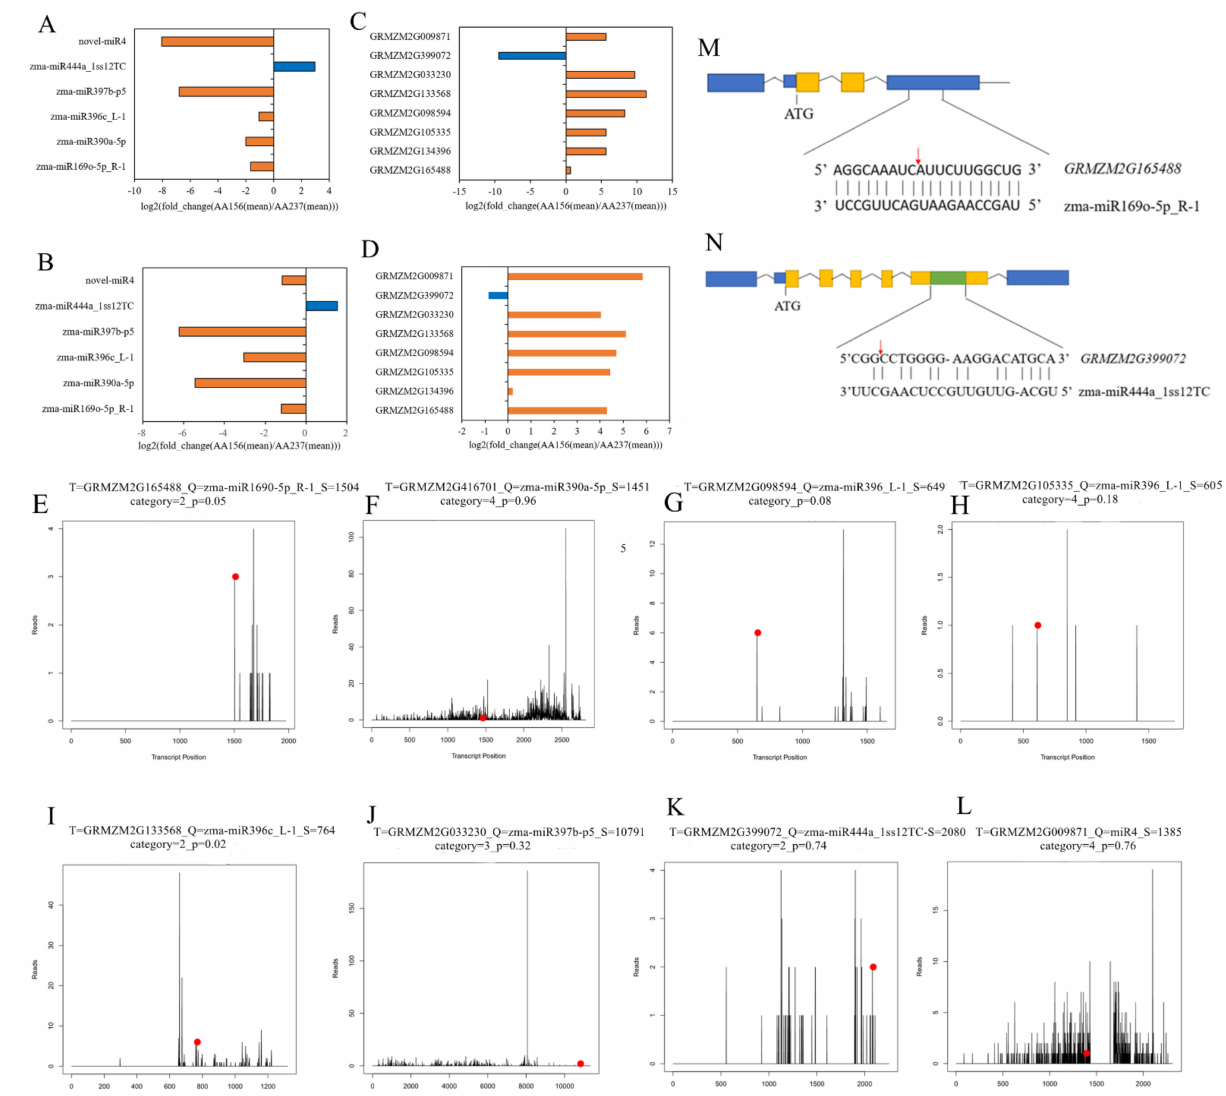
Figure 3. The miRNA, target, and degradation product abundances by RNA seq and validation by alternative methods. ( A ) high throughput sequencing to verify miRNA, the orange bars indicate the up-regulated miRNA and the blue bars indicate the down-regulated miRNA. ( B ) qRT-PCR to verify miRNA, the orange bars indicate the up-regulated miRNA and the blue bars indicate the down-regulated miRNA. ( C ) high throughput sequencing to verify target genes, the orange bars indicate the up-regulated target genes and the blue bars indicate the down-regulated target genes. ( D ) qRT-PCR to verify target genes, the orange bars indicate the up-regulated target genes and the blue bars indicate the down-regulated target genes. ( E – L ) the relative abundance of zma-miR169o- 5p, zma-miR390a-5p, zma-miR396c_L-1, zma-miR397b-p5, zma-miR444, and novel-miR4 and their target genes. The red dot is the same position of the predicted target gene and the degradation site obtained from the degradome sequencing, and the black line is the actual degradation site measured in the degradome sequencing. ( M ) zma-miR169o-5p_R-1 acts on the cleavage site of the target gene GRMZM2G165488 were confirmed by 5 (cid:48) RLM-RACE. ( N ) zma-miR444a_1ss12TC acts on the cleavage site of the target gene GRMZM2G399072 were confirmed by 5 (cid:48) RLM-RACE. The yellow bars represent the exon part of the gene, the green bars represent the cutting site part of the target gene, the black broken line represents the intron part of the gene, and the blue bars represent other structures of the